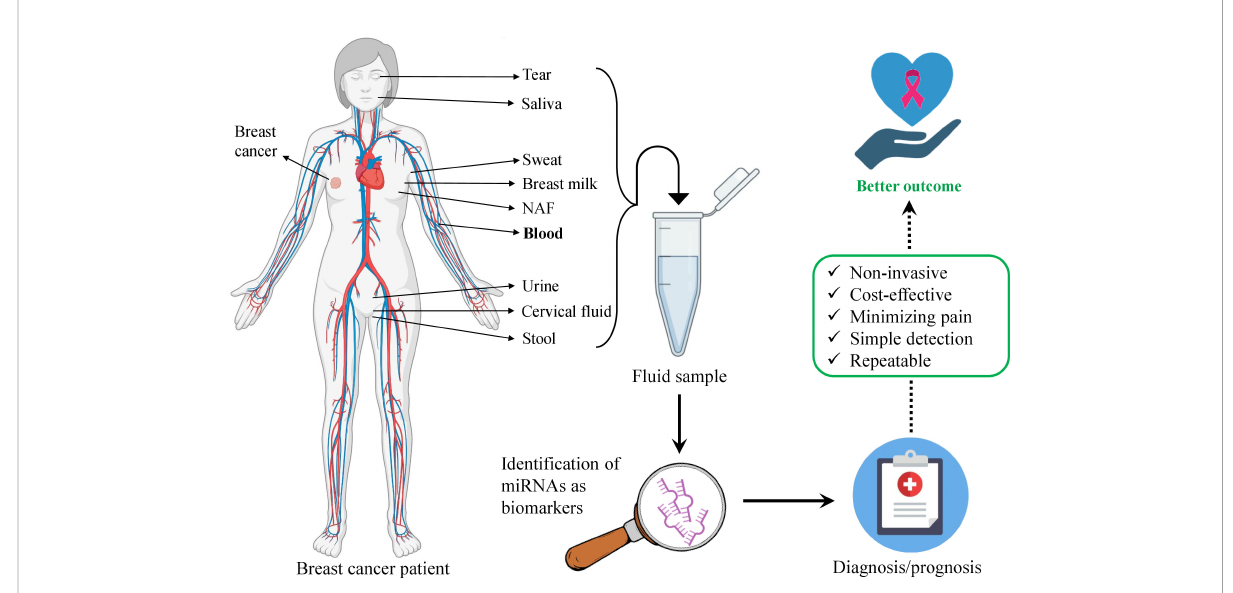
FIGURE 1 Schematic illustration of body fl uids-based miRNA utility as biomarkers in breast cancer diagnosis and prognosis. The body fl uids are the source of miRNAs that can be obtained via liquid biopsy. Bold-type indicates the most promising and studied body fl uid for detecting miRNAs in breast cancer. Several listed bio fl uids have not yet been studied for miRNA detection as biomarkers in breast cancer, still, they represent potential liquid biopsy